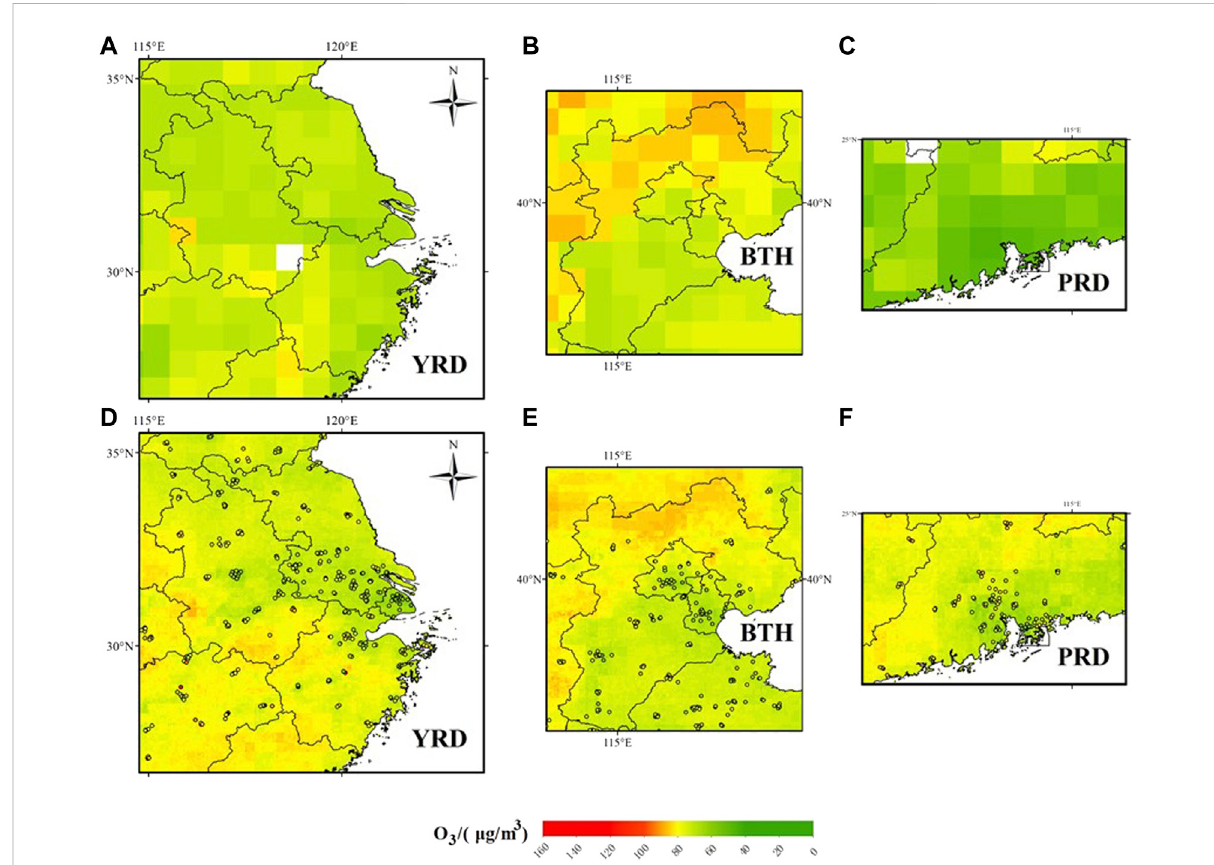
FIGURE 8 Downscaling results based on the MI method in YRD, BTH, and PRD. (A) and (D) are the 30 km TROPOMI surface O 3 concentration image and the1 kmTROPOMIsurfaceO